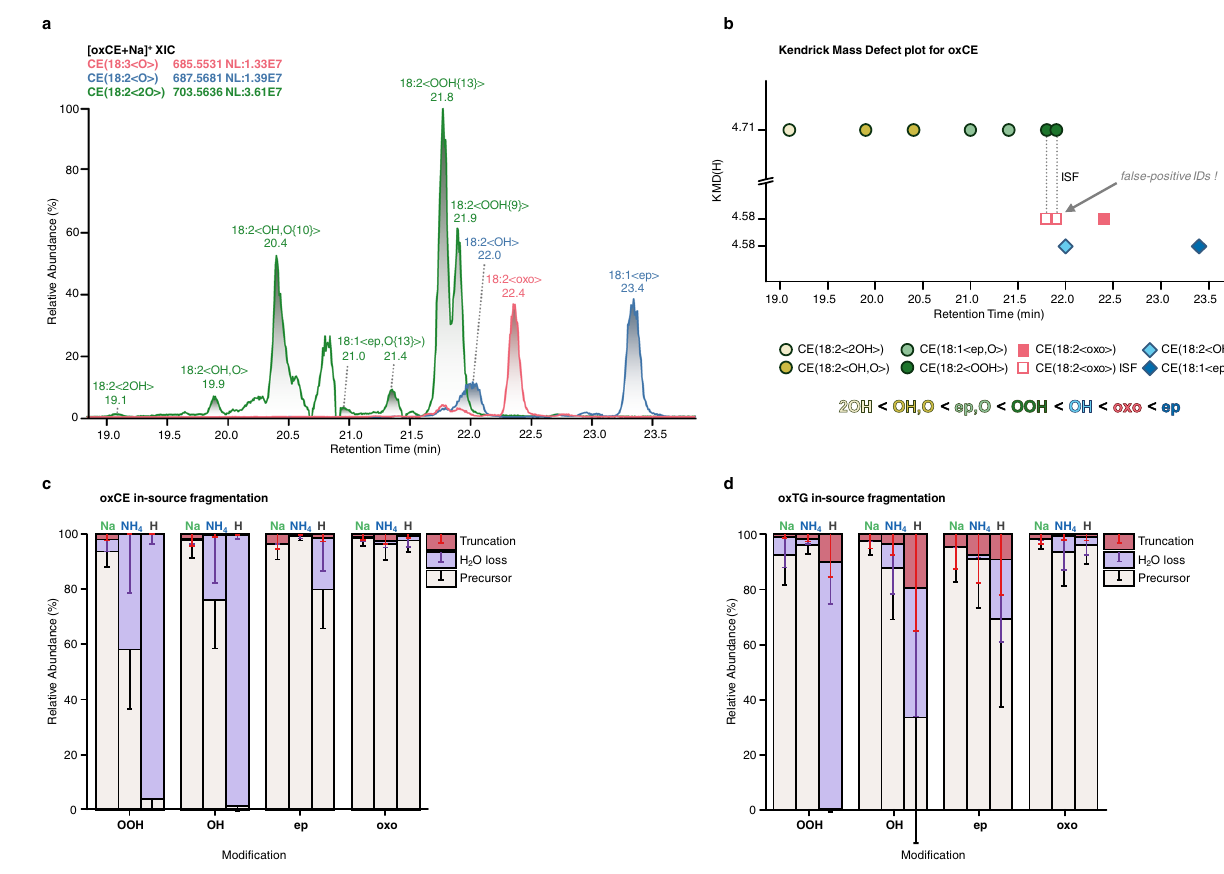
Fig. 3 | LC-MS/MS coupling and retention time (RT) mapping facilitate reso- lution of isomeric oxidized lipids and allow to correct for in-source fragmen- tation (ISF). Isomeric oxidized lipids can be successfully resolved by RPC, as illustrated here for mono- (CE(18:3<O>) in red and CE(18:2<O>) in blue) and diox- ygenated (CE(18:2<2O>)in green) oxCElipids ( a ).RT mapping using KMD(H)plots allows visual inspection of isomer-speci fi c elution order as well as identi fi cation of falsepositiveannotationduetotheISF( b ).TheextentofISFforoxCE( c )andoxTG